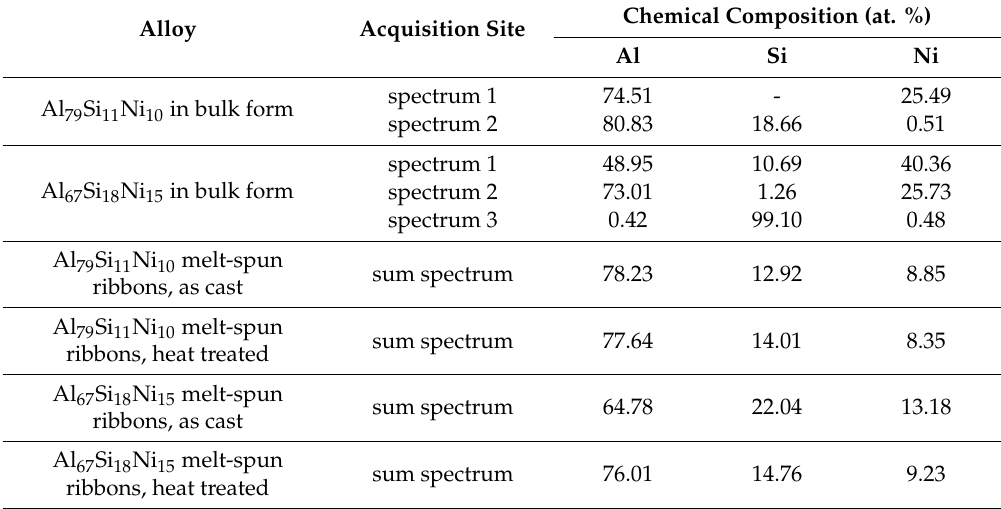
Table 2. The surface chemical composition, obtained by energy dispersion spectroscopy system. Chemical Composition (at. %) Alloy Acquisition Site Al Si